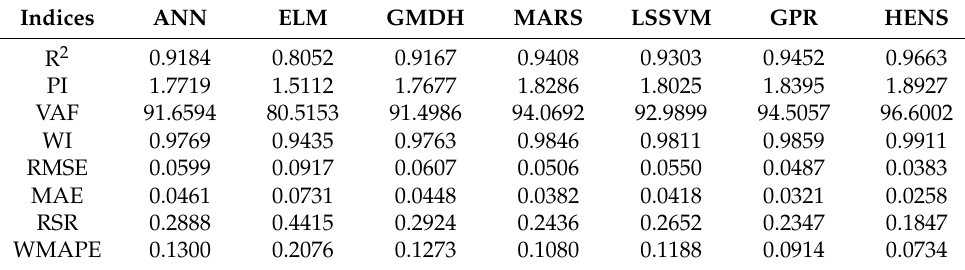
Table 6. Performance indices for the total